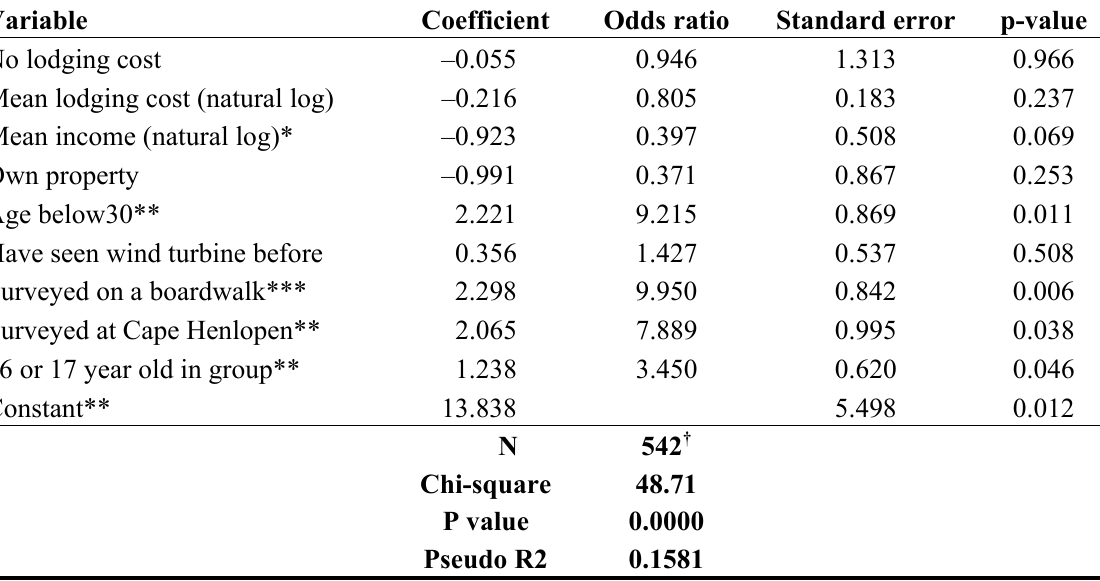
Table 7. Logit regression of the likelihood of visiting a Delaware beach if a 10-kilometer wind farm existed off the coast of sampled tourist